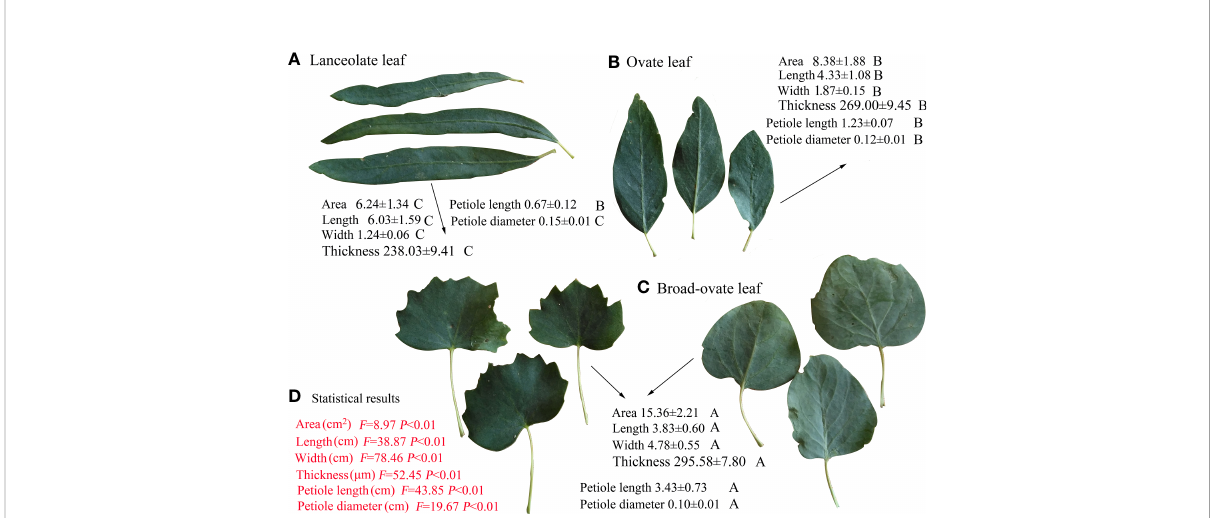
FIGURE 2 Differences in morphological traits among the three types of heteromorphic leaves. The values of P and F are the statistical results of one-way ANOVA. Different letters on the back of the related variables indicate the signi fi cant differences among heteromorphic leaves, while the same letters show the insigni fi cant difference. Values are represented as mean ± SD.